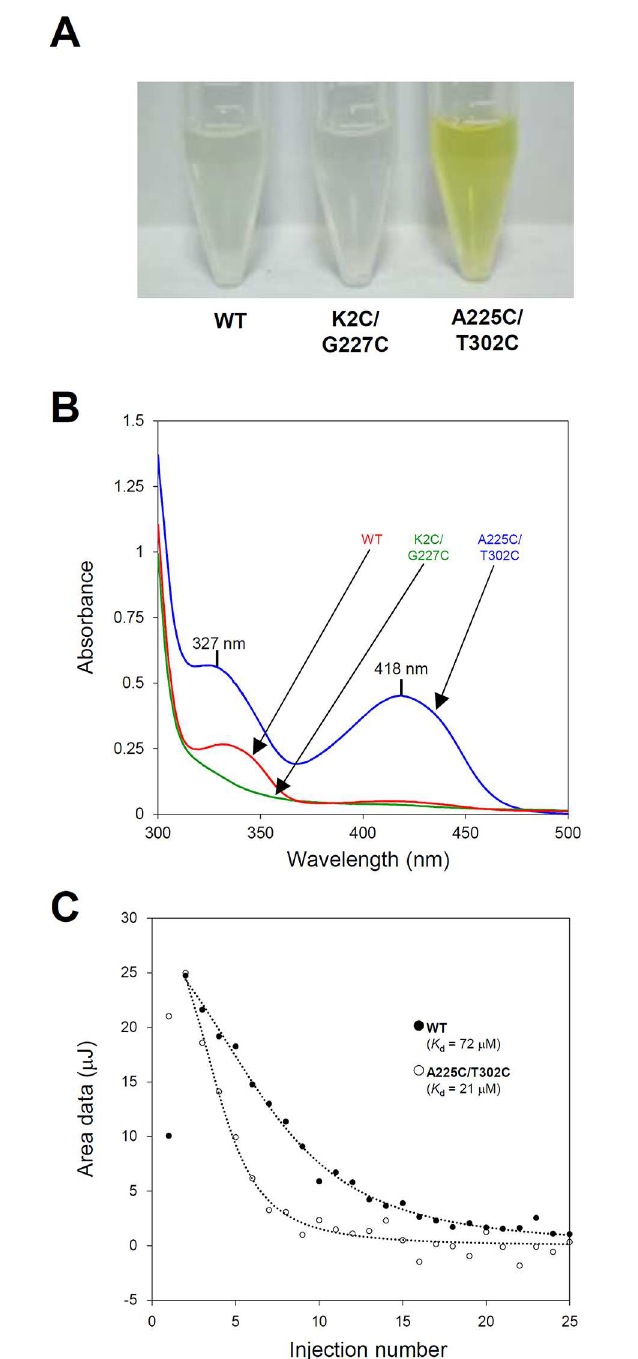
Fig 2. Enhanced PLP affinity in the Sr LDC A225C/T302C mutant. ( A ) Purified recombinant Sr LDC proteins. The purified Sr LDC WT , Sr LDC K2C/G227C , and Sr LDC A225C/T302C proteinswith concentration of 1 mg/ml are shown. ( B ) UV/vis spectra of recombinant Sr LDC proteins. The UV/Vis absorptionspectra of recombinant Sr LDC proteinsare shownand labeledappropriately. The bandpeaks of 327 nm and 418 nm observedin the Sr LDC A225C/T302C mutant are indicated. ( C ) Isothermal titration calorimetry of Sr LDC WT and Sr LDC A225C/T302C mutant. K d values of Sr LDC WT and the Sr LDC A225C/T302C mutant are displayed.